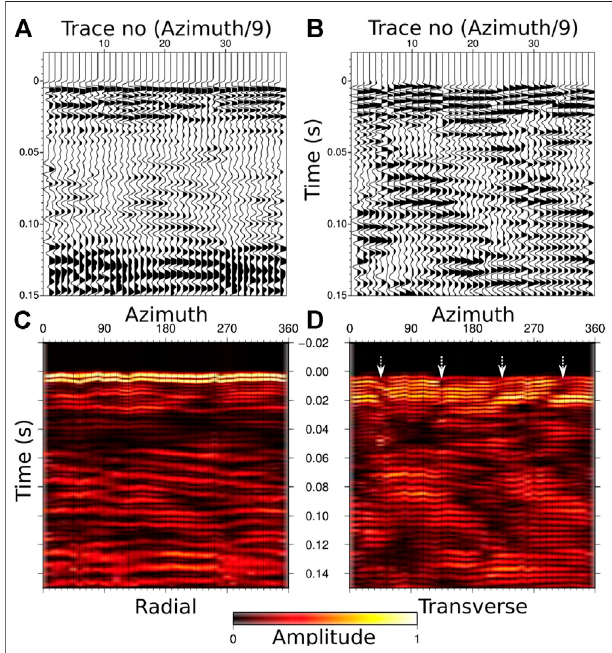
FIGURE 8 | 9 ° azimuth stacks recorded on OBS19 located in the reference site. Left and right panels show radial and transverse components respectively. (A) Radial wiggle plot. (B) Transverse wiggle plot. No C-wave eventisobservedontherecordsofthisOBS. (C) Radialenvelopeplotof the amplitudes (root of squared amplitudes). (D) Transverse envelope plot. Dashed white arrows (at t (cid:2) 0) show the geophone